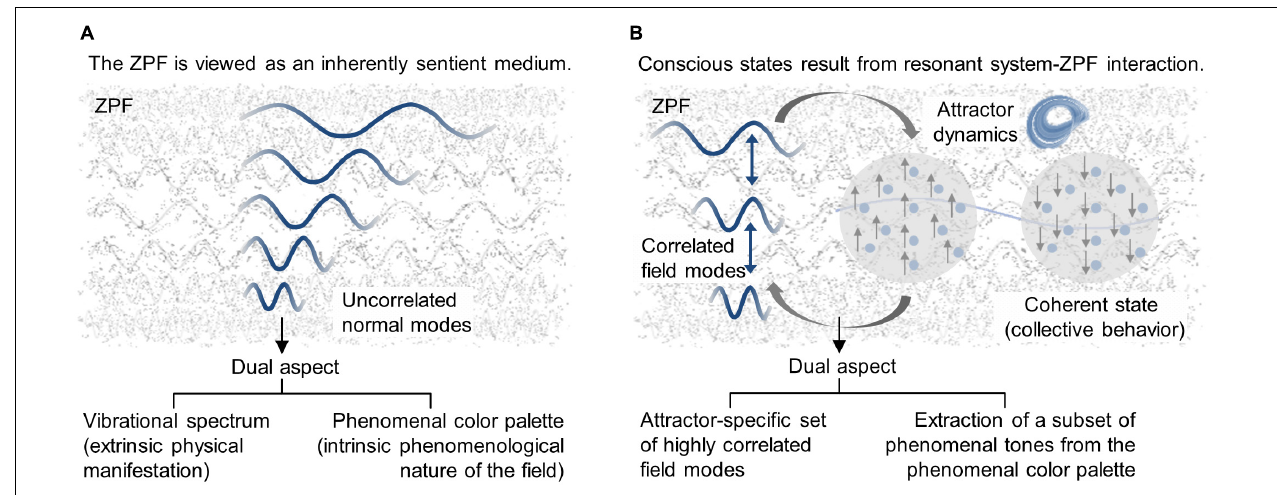
FIGURE 1 | Toward a self-consistent EM field theory of consciousness. (A) The zero-point field (ZPF) is assumed to be a foundational dual-aspect component of the cosmos, the extrinsic manifestation of which is physical in nature and the intrinsic manifestation of which is phenomenological in nature. (B) It is postulated that conscious systems employ a universal mechanism through which they tap into the phenomenal color palette predetermined by the ZPF. According to this mechanism, conscious states are caused by resonant system-ZPF interaction, as a result of which the system falls into an attractor and the relevant ZPF modes involved in the interaction combine into an attractor-specific set of highly correlated field